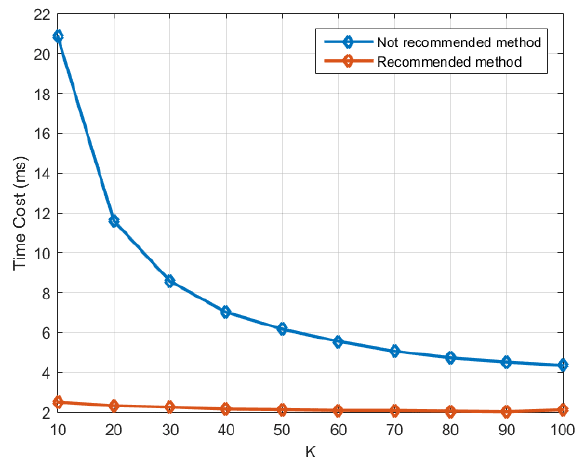
Figure 13. Comparison between the two implementation methods introduced in Section 4.3 and Section 4.4 in the context of SFAP. The parameters M and N were 4 and 256, respectively.